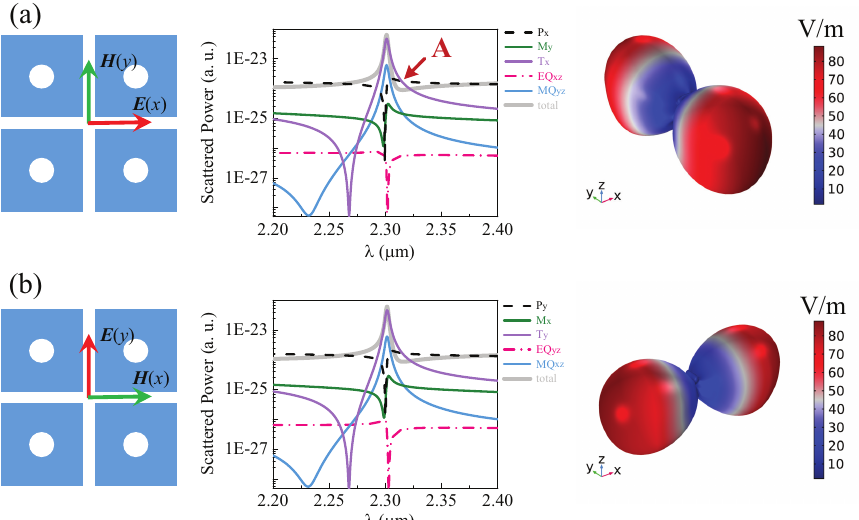
Figure A1. The scattered power of different multipoles and far-field radiation pattern at the resonant wavelength under ( a ) the x polarization and ( b ) y polarization,